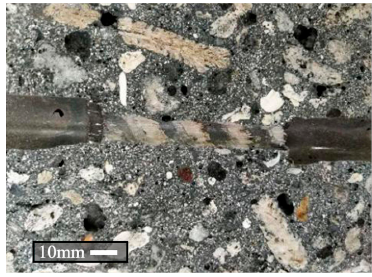
Figure 19. Effects of nominal bond length: ( a ) τ avg-max ; ( b ) τ s.